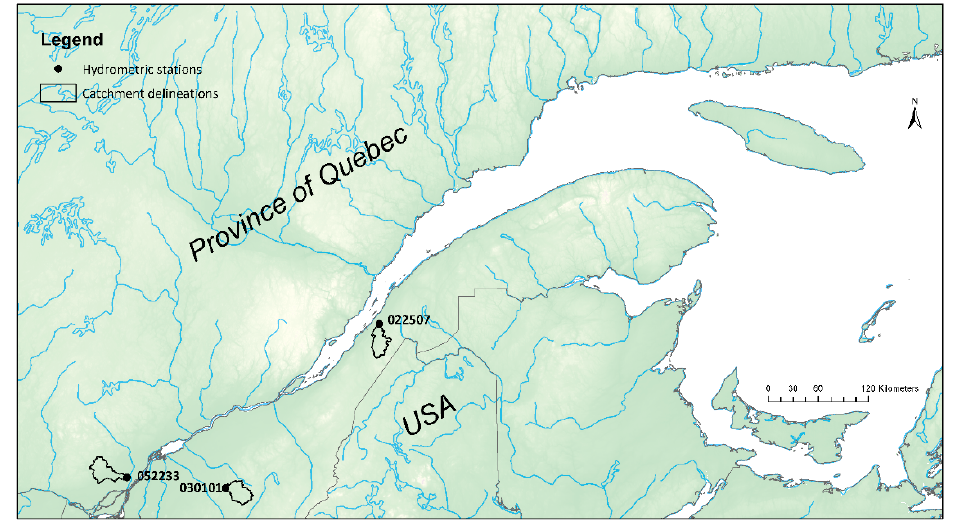
Figure 3. Du Loup (022507), Nicolet Sud-Ouest (030101) and De l’Achigan (052233) catchments.